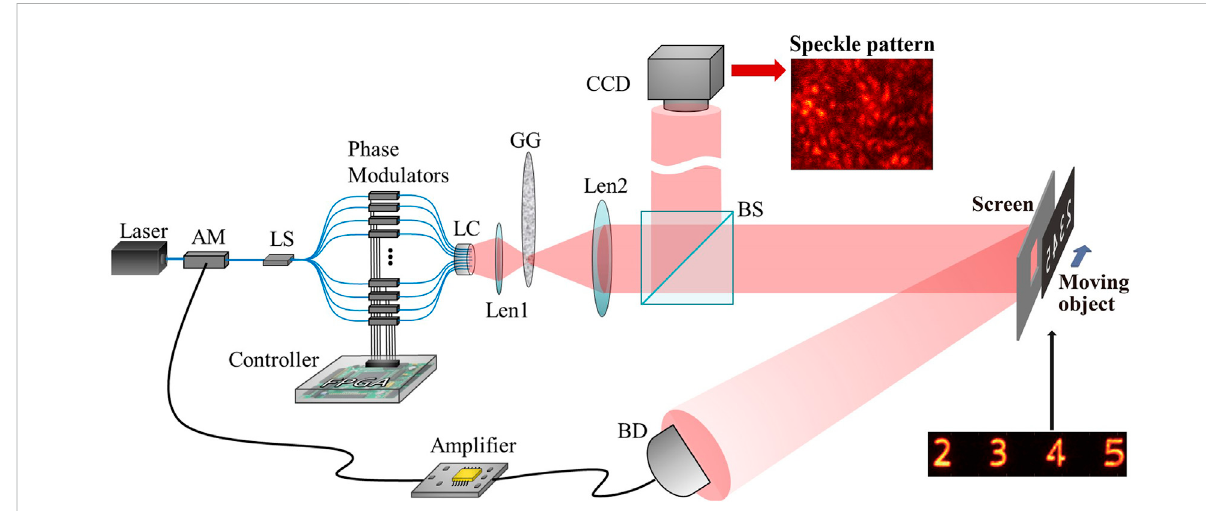
FIGURE 1 Schematic of the experiment. The intensity of a laser beam is modulated using an electro-optic amplitude modulator (AM) and then is split into 30 sub-beams with a light splitter (LS). Each sub-beam is input into an EOPM, which changes its phase at a very high rate. The other ends of the EOPMs are randomly stacked together, constructing a light combiner (LC). The light emitted from the OPA is focused onto a rotating ground glass (GG) with a lens (Len1). The scattered light from GG is collimated and projected toward the scene. The light re fl ected from a moving object is detected using a bucket detector (BD). The signal of BD is ampli fi ed with an ampli fi er and is then used to drive AM in real time. A beam splitter (BS) is placed right behind Len2 to copy the light patterns to a CCD camera that directly displays the image of the object after accumulating hundreds of time-varying patterns in a certain exposure time. A screen with an aperture is placed in front of a moving object. At the right-bottom is the pro fi le of theobject.ThedistancebetweenLen2andtheobjectis400 mm ,soisthedistancefromLen2tothecamera.ThefocuslengthofLen1is25 mm .The focus length of Len2 is 300 mm . The distance between LC and Len1 is ~ 80 mm . The distance between Len1 and GG is ~ 36 mm . The distance between GG and Len2 is ~ 300 mm .